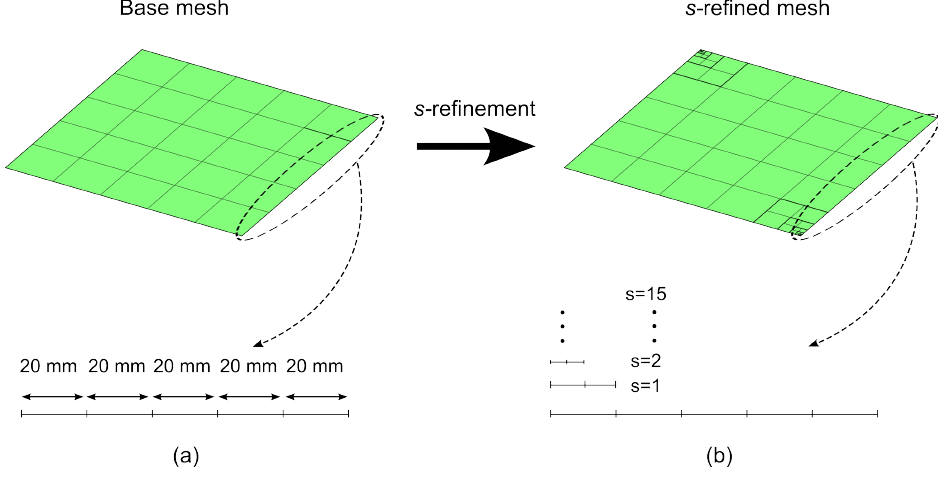
Figure 15. Highlyanisotropic plate – vibration and buckling analysis: ( a ) Base mesh, ( b ) s − refined